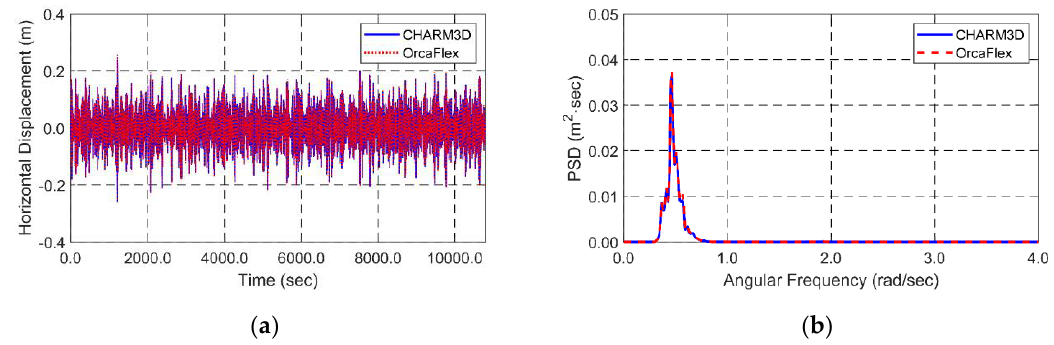
Figure 7. Time histories ( a ) and spectrum ( b ) of horizontal displacement of the tunnel in the middle location under the 100-year-strom waves.